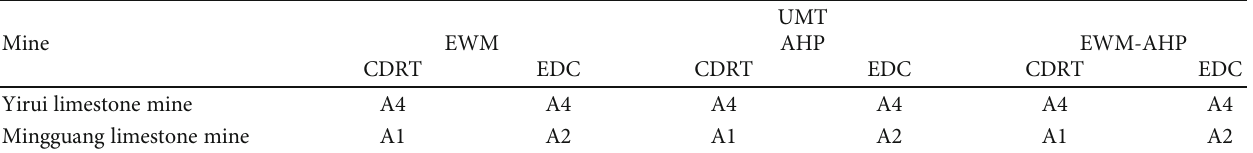
Table 13: GM grades for Yirui limestone mine and Mingguang limestone mine.